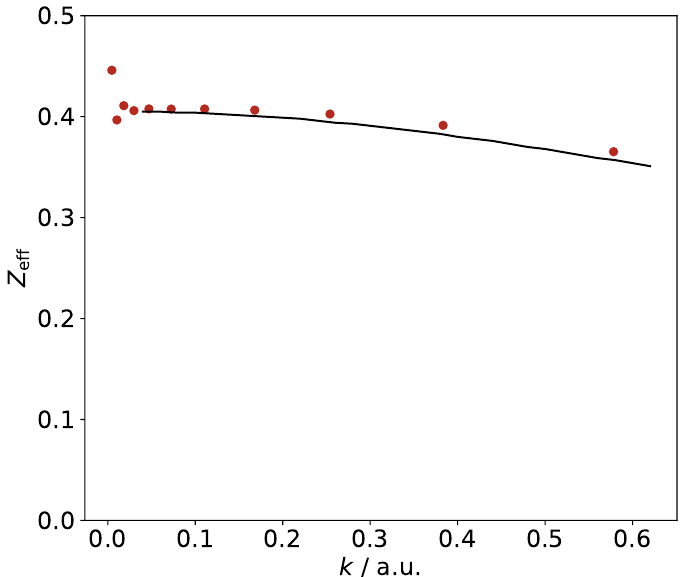
Figure 9. Red circles: values of Z eff obtained in the one-particle model with variational wavefunctions from (48). Black line: Z eff data obtained for the frozen-target model from atomic codes